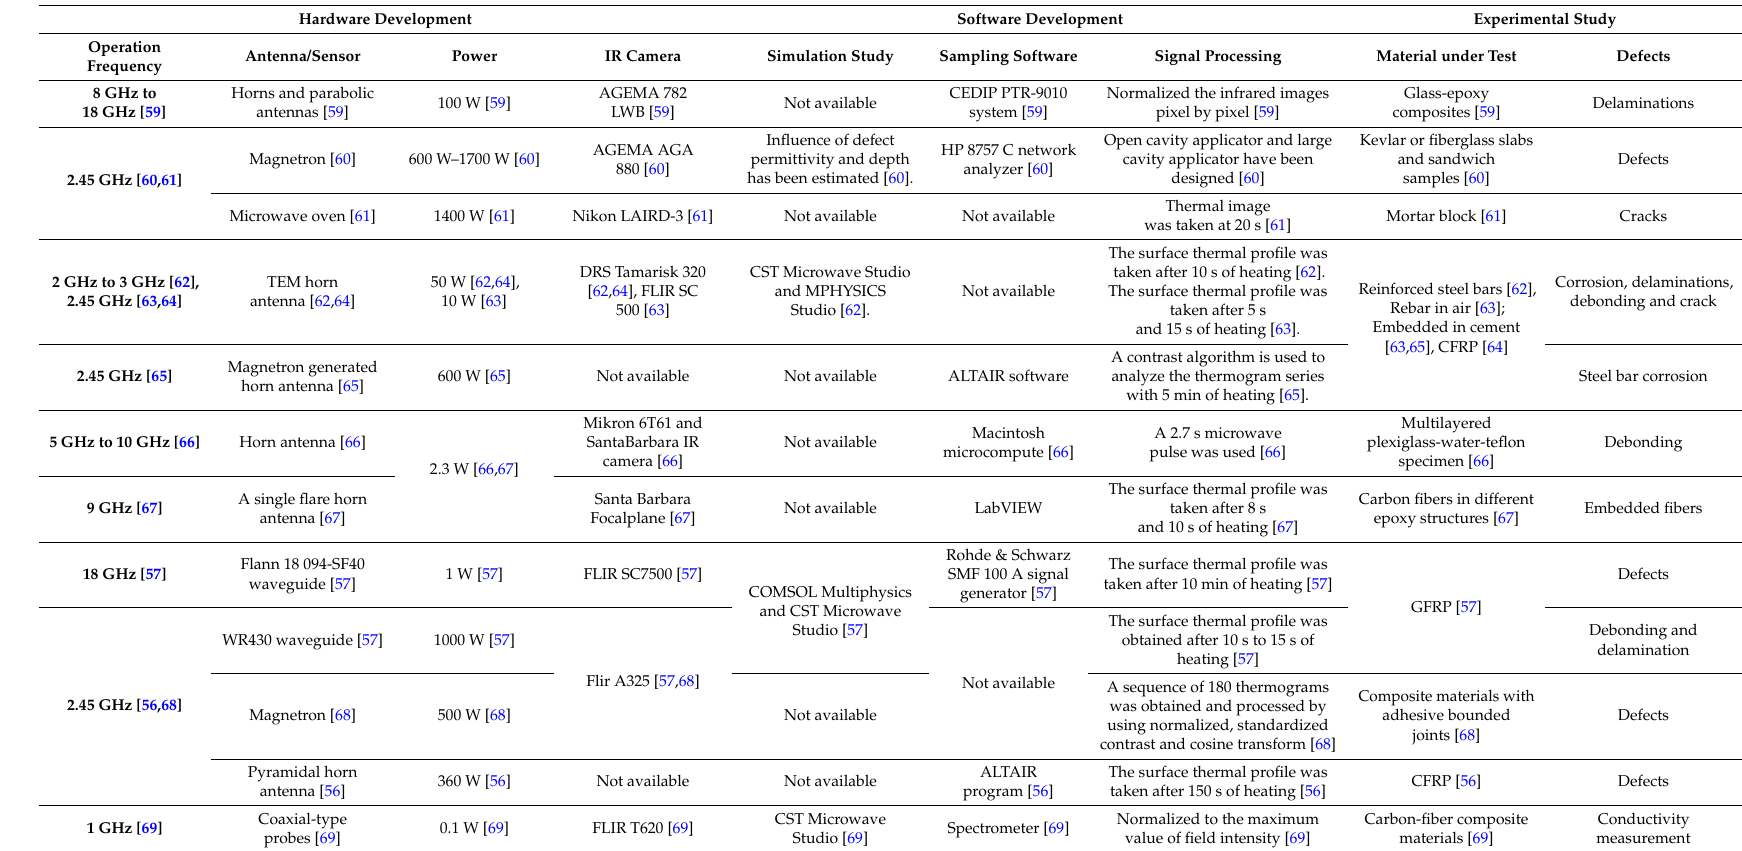
Table 2. Summary of researches with